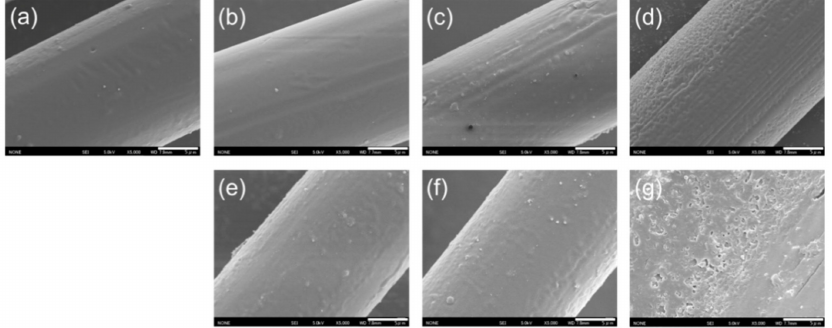
Figure 4. SEM images of plasma-treated PLA fibers: ( a ) untreated PLA fiber; ( b ) P1; ( c ) P2; ( d ) P3; ( e ) P4; ( f ) P5; and ( g ) P6 (magnification: 5000 × , scale bar: 5 µ